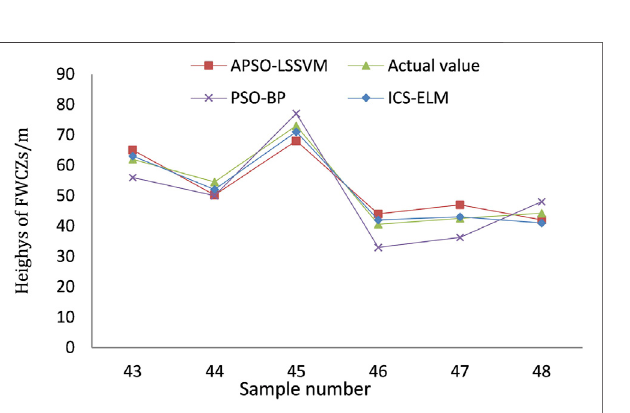
FIGURE 4 | Comparison of prediction results of the training set based on the ICS – ELM model.